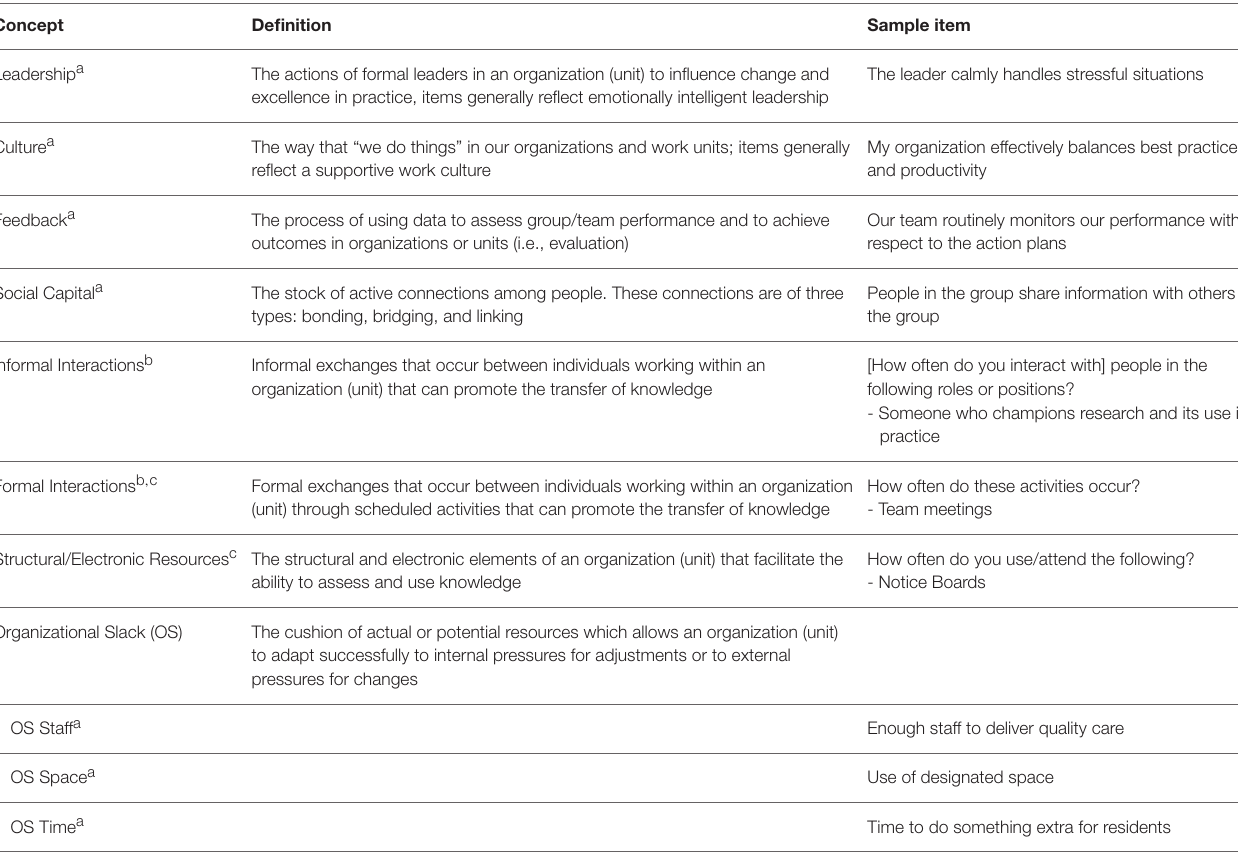
TABLE 1 | Concepts, definitions and example items of the Canadian Alberta Context Tool Long Term Care version (Estabrooks et al.,